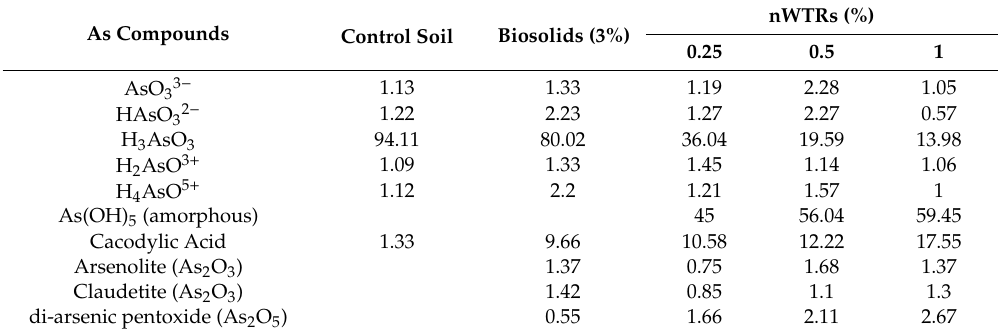
Table 3. Arsenic speciation (%) in soil solution of the calcareous soil that was amended with biosolids and nanoscale WTRs, using the MINEQL + modeling